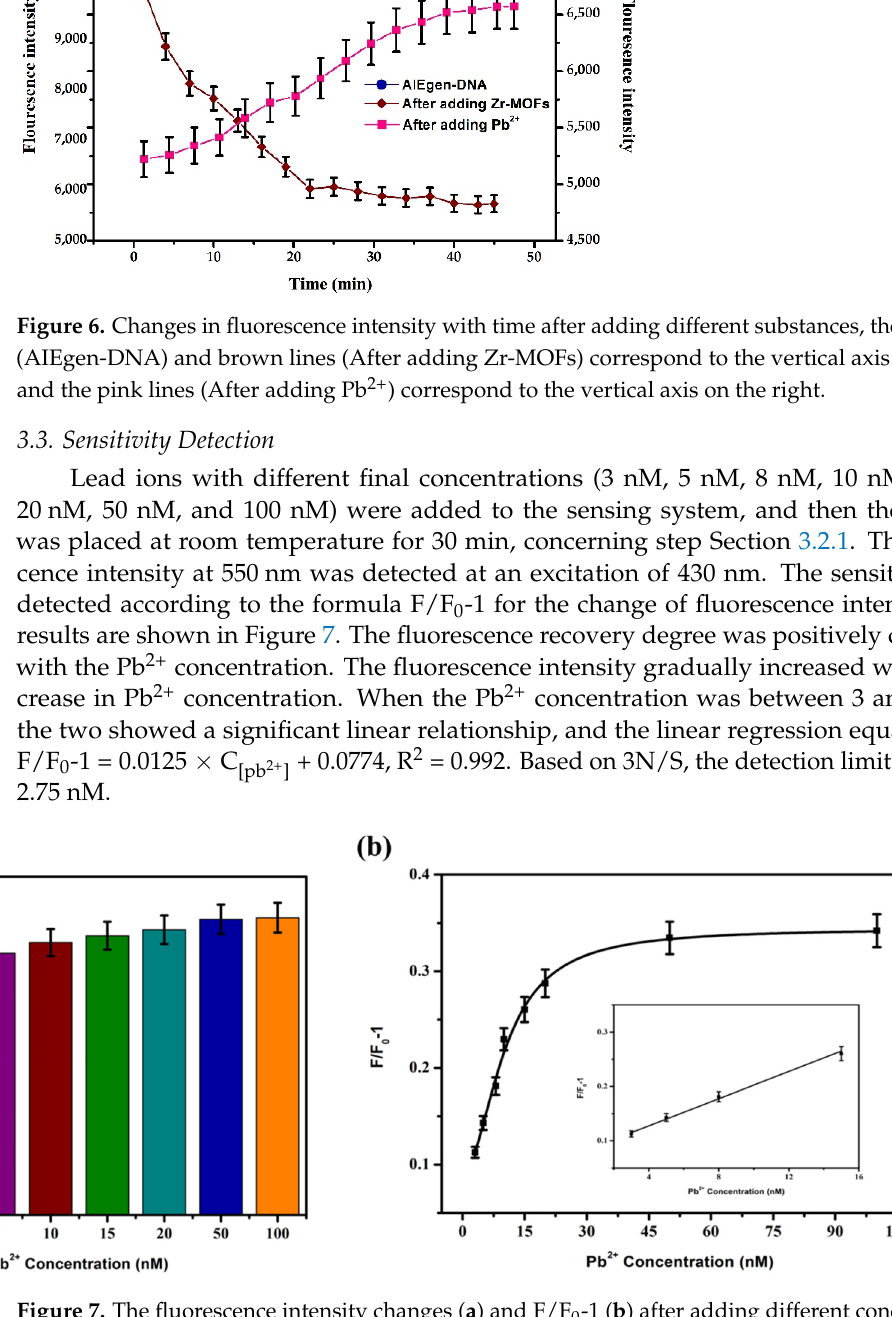
Figure 7. The fluorescence intensity changes ( a ) and F/F 0 -1 ( b ) after adding different concentrations of Pb 2+ into the sensor.